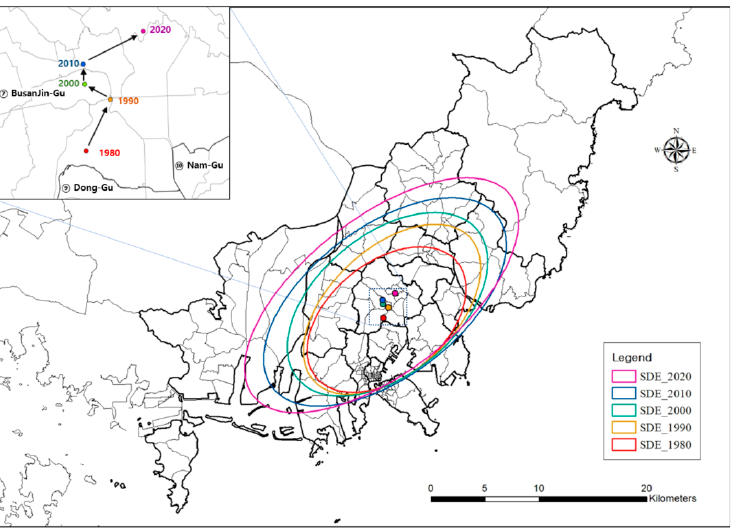
Figure 5. SDE in BMC. Note: The base map was adopted from the National Spatial Data Infrastructure Portal of Korea (www.nsdi.go.kr (accessed on 12 August 2022)).